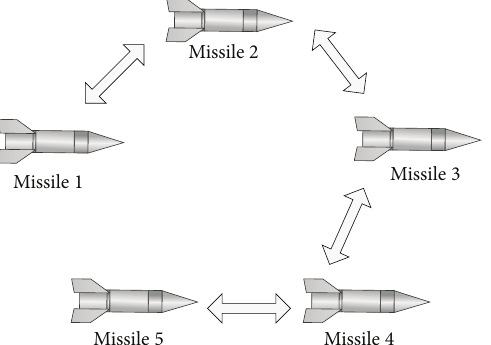
Figure 6: Topological structure of the network.